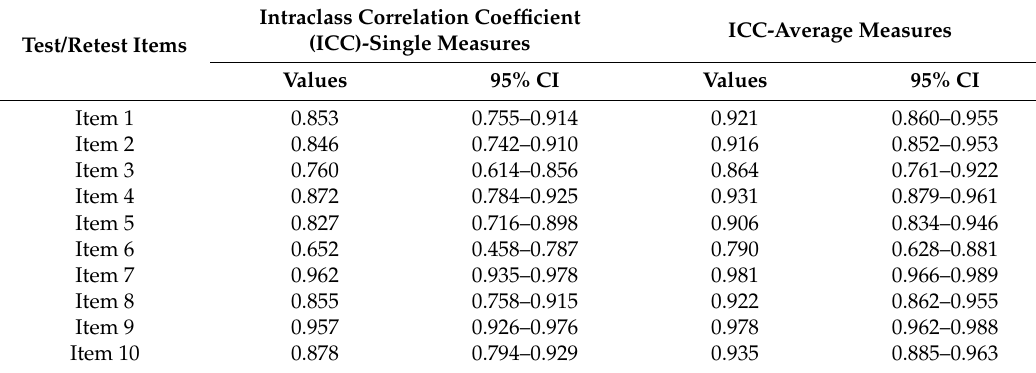
Table 3. Test/retest reliability (interclass correlation coefficient) of the Serbian version of the Dysfunctional Voiding Symptom